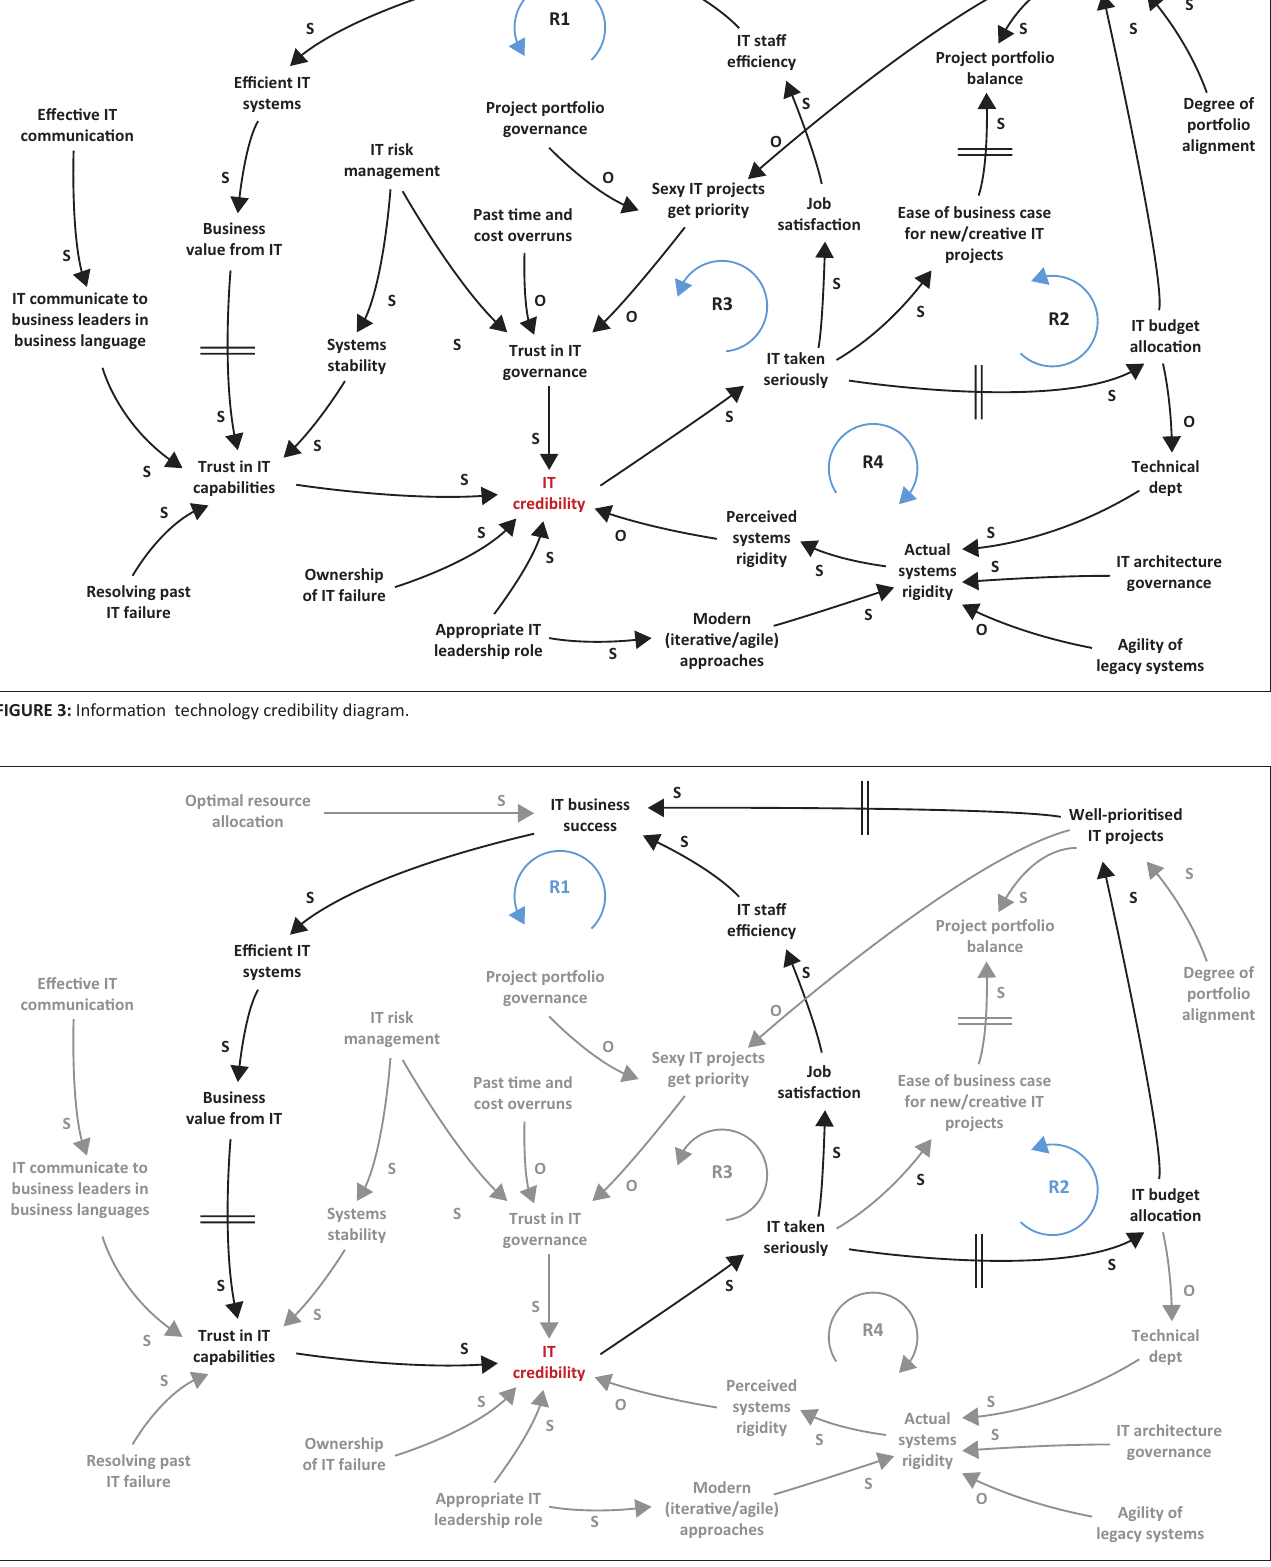
FIGURE 4: Information technology credibility reinforcing feedback loops R1 and